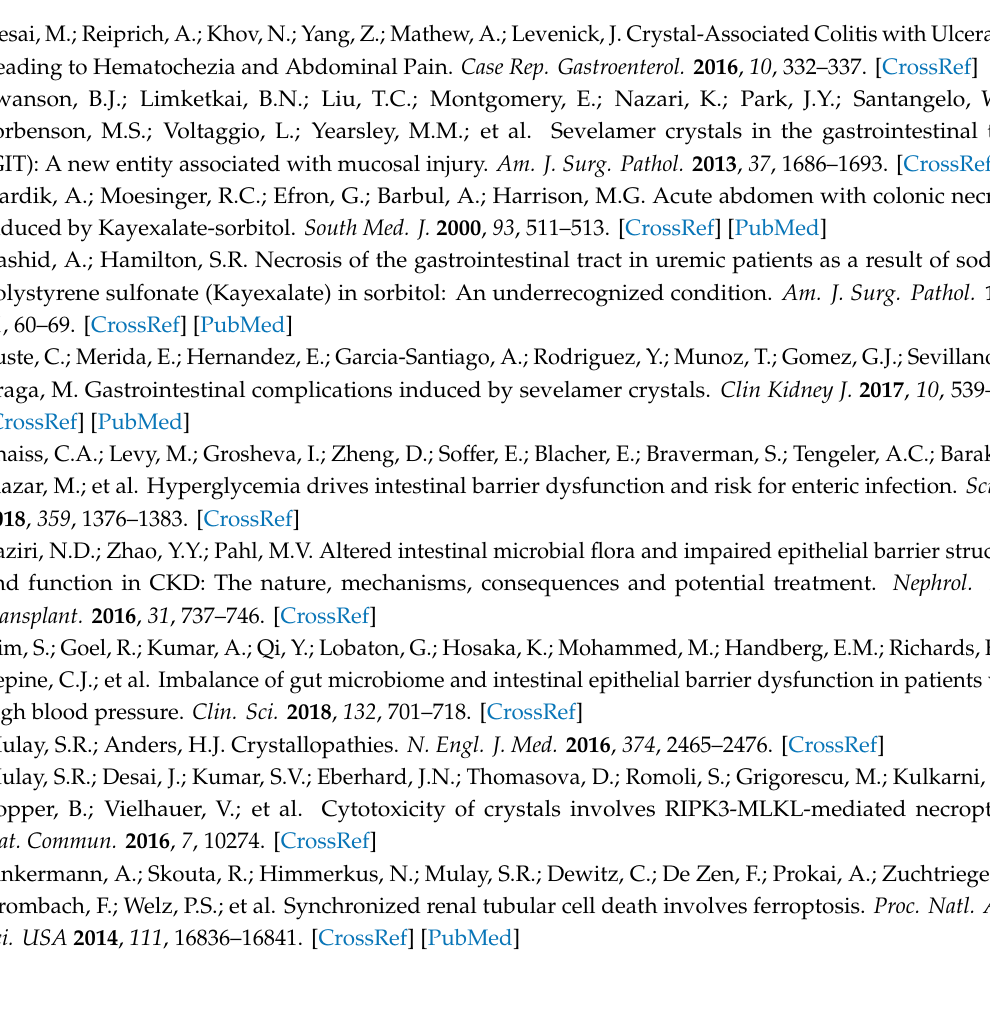
Figure S1: Patiromer crystals reduce the metabolic activity in intestinal epithelial cells. Figure S2: Drug crystals induce only slight cell death in HCA7 intestinal epithelial cells. Figure S3: Monosodium urate crystals induce neutrophil extracellular trap